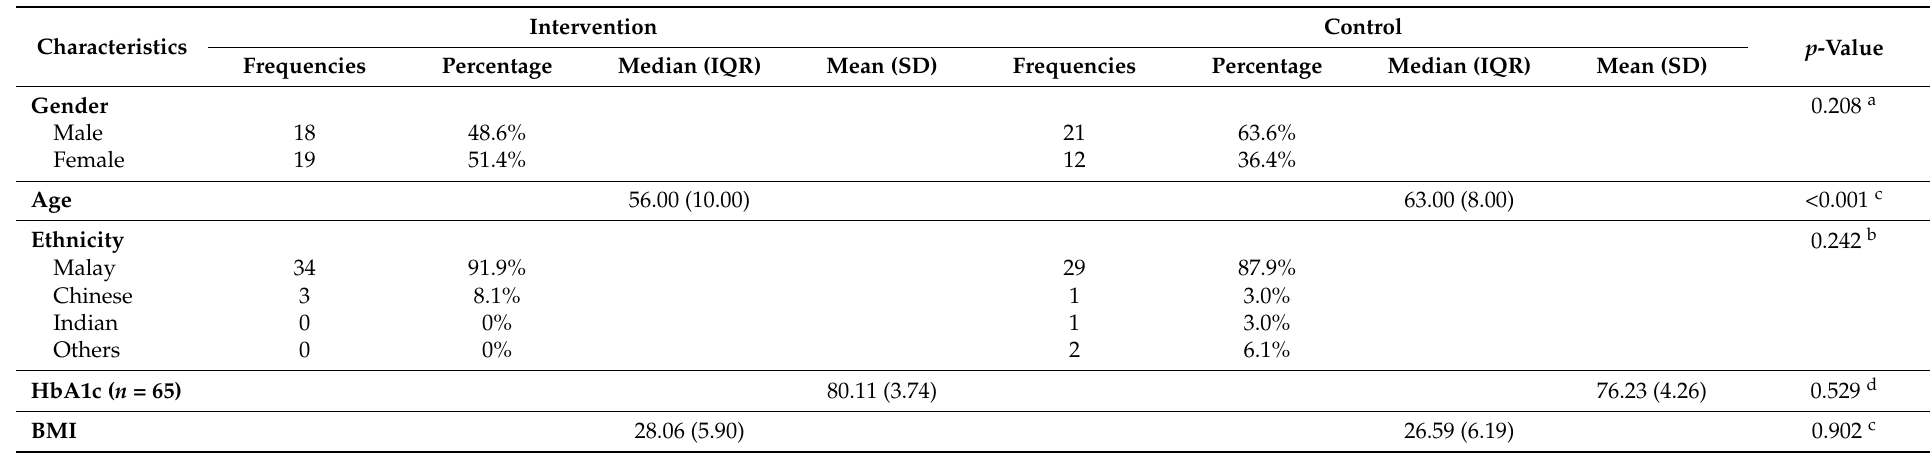
Table 1. Participants demographic